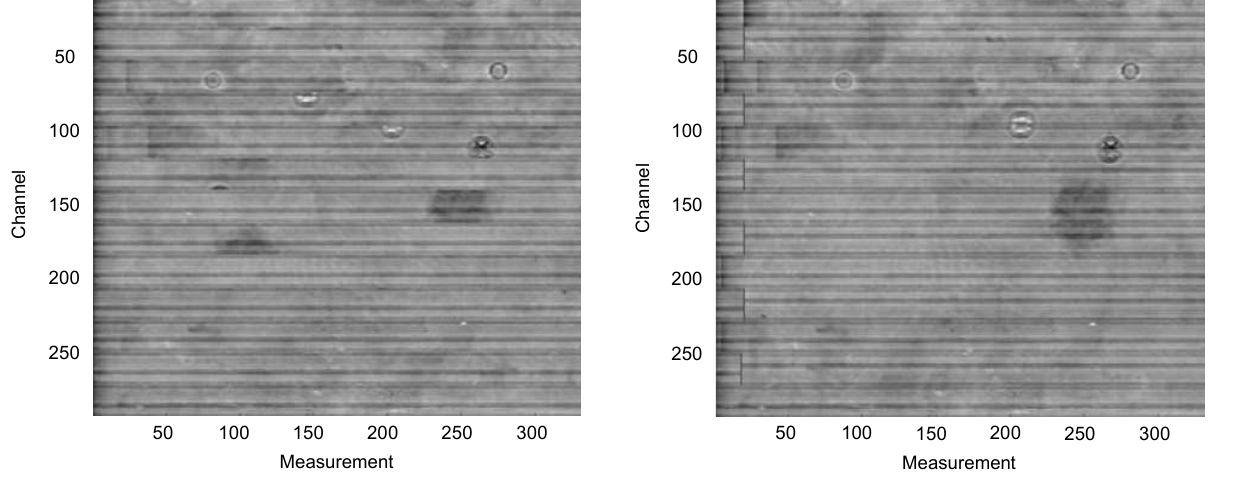
Figure 5 . Before (left) and after (right) applying a dewow filter.